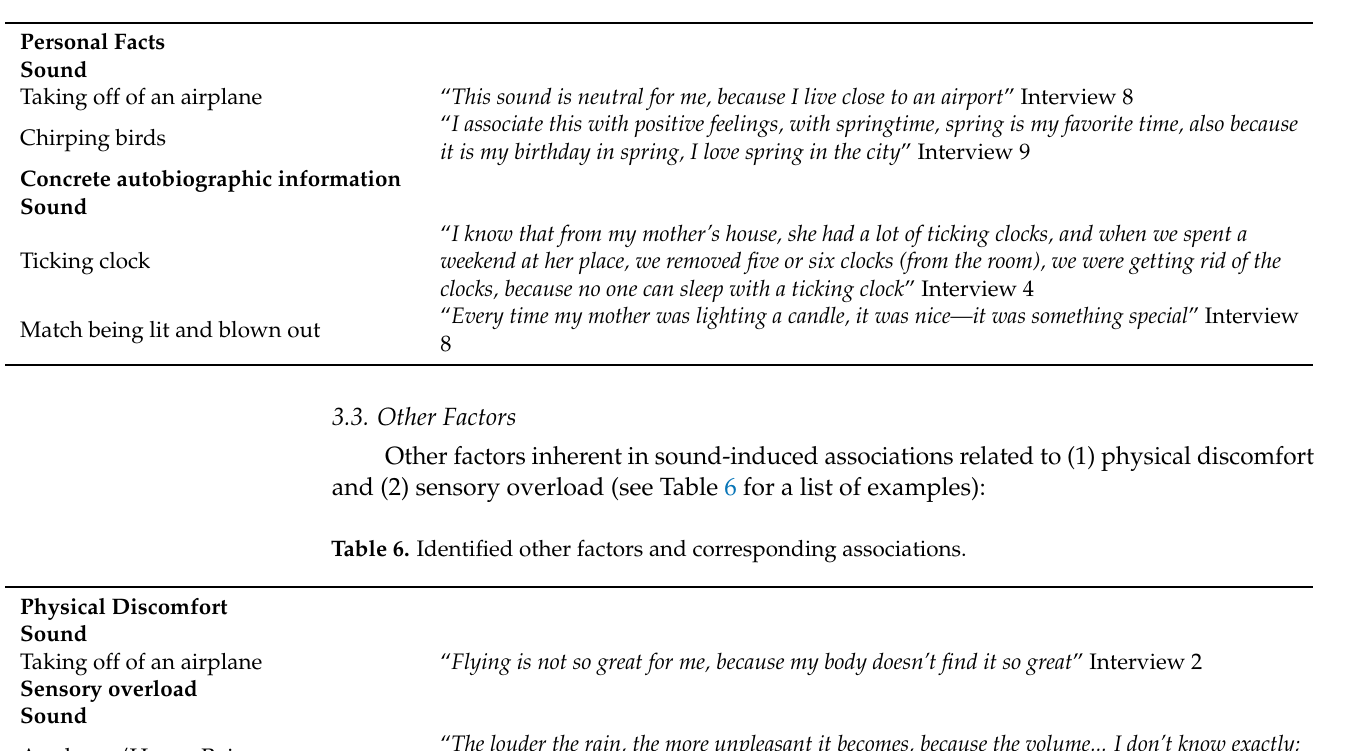
Table 5. Identified episodic memory-related factors and corresponding associations.